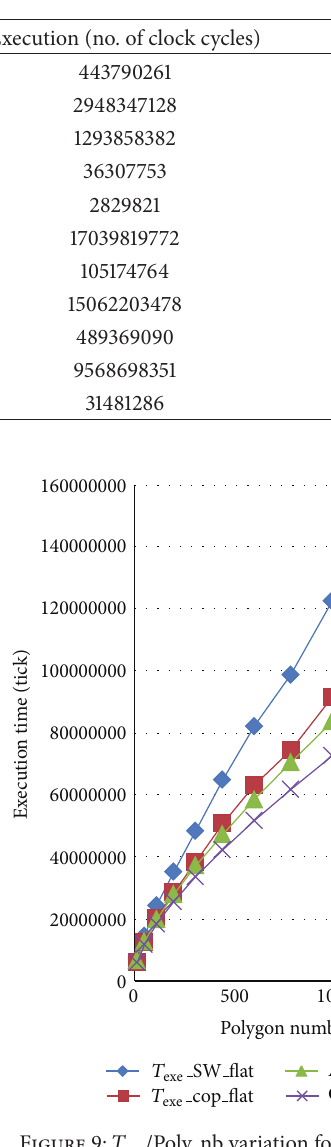
Table 4: Profiling result of the 3D synthesis using performance counter on Nios IDE.